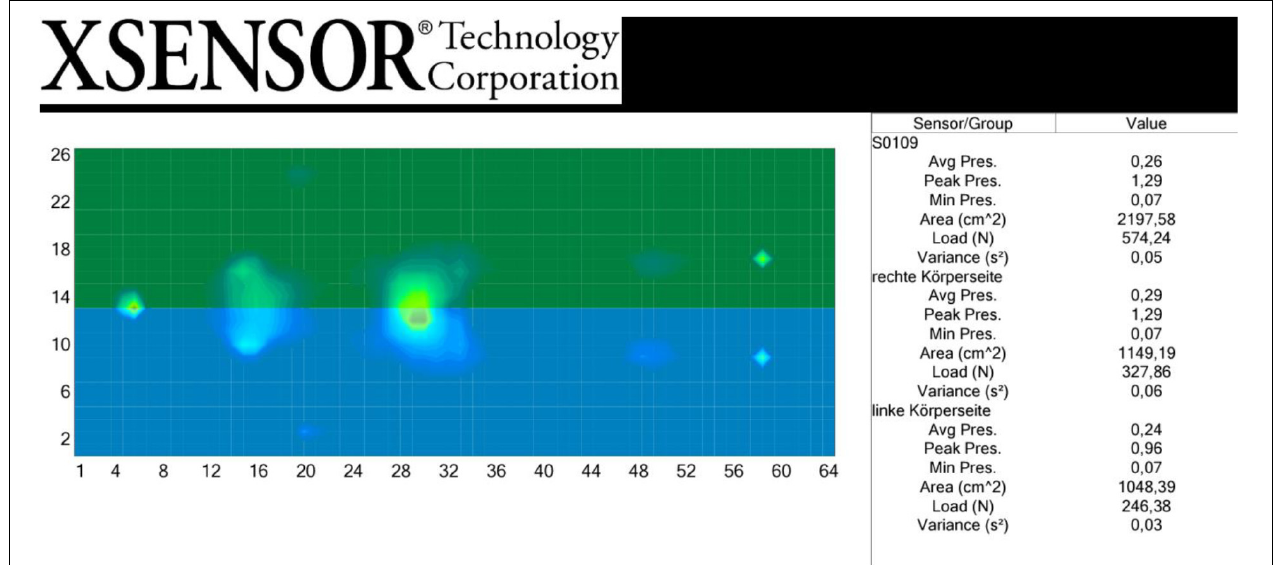
FIGURE 2 | Example for Xsensor-measurement